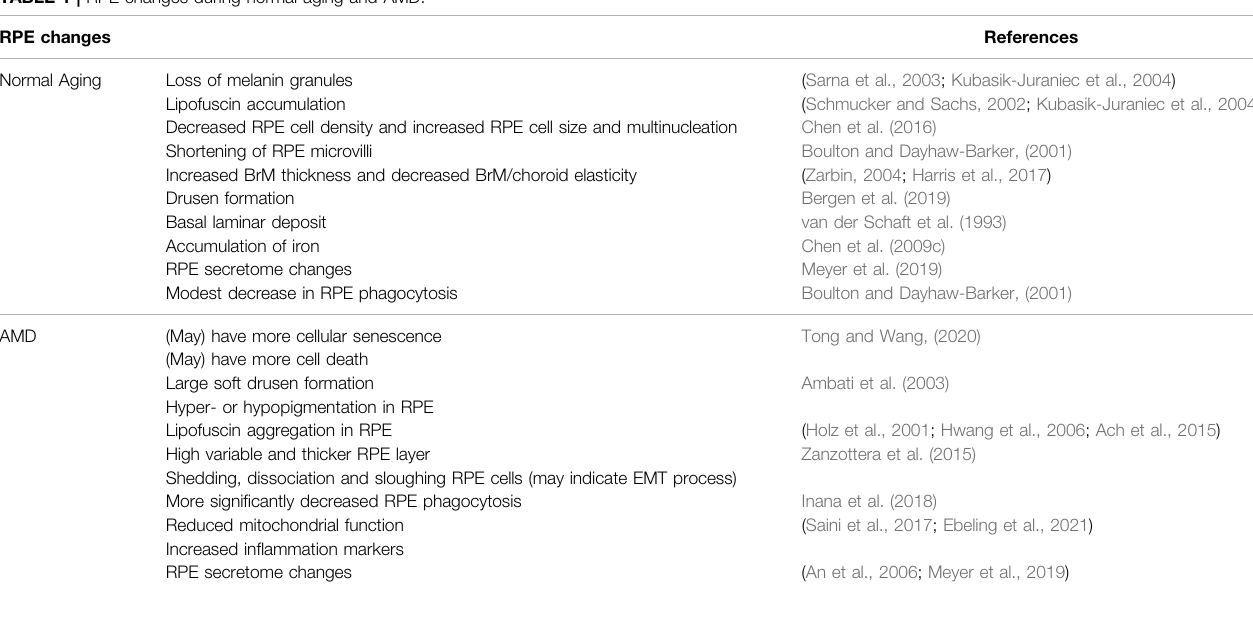
TABLE 1 | RPE changes during normal aging and